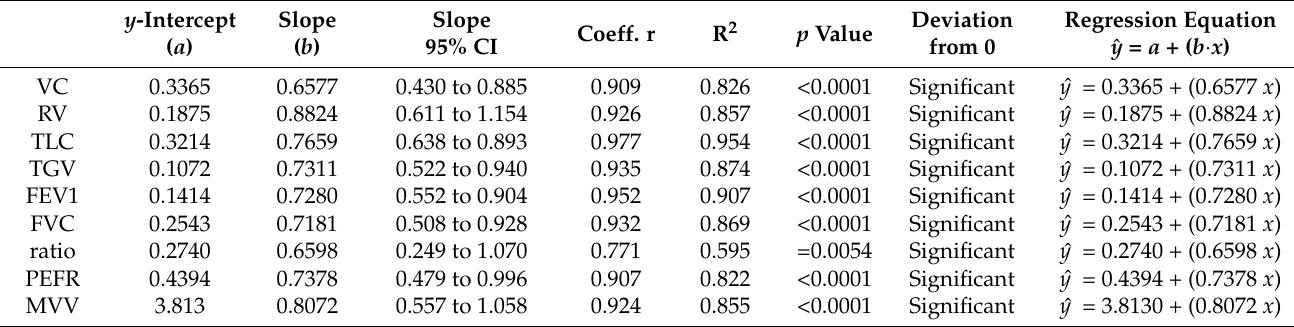
Table A1. Linear regression of y (outcome variable) on x (predictor variable) analysis. For each parameter, ˆ y is the predicted value of y , estimated for a specific predictor value x by the simple linear regression equation. y